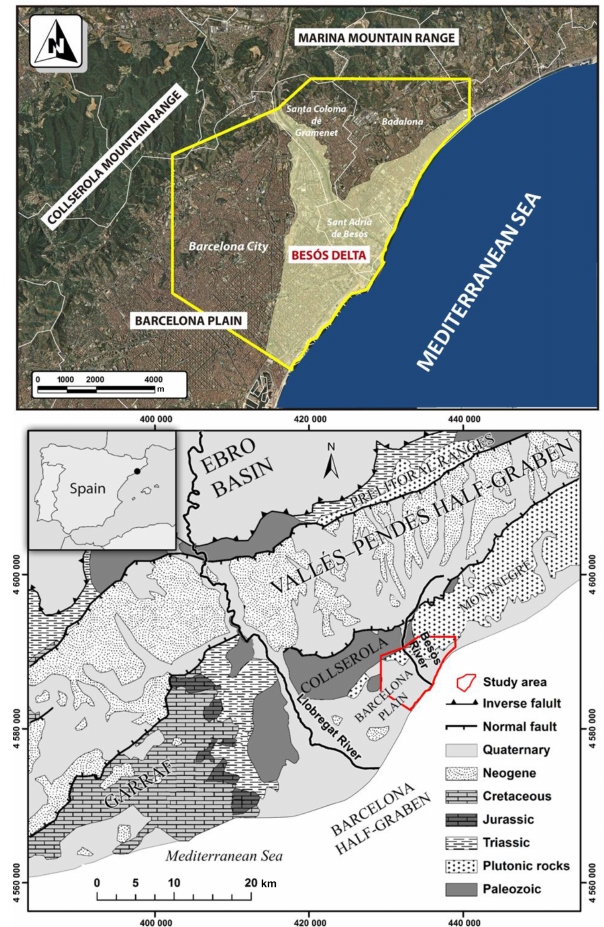
Figure 1. Top: orthophotograph of the northeastern Mediterranean coast of Spain covering the extent of the Barcelona study area (IGN PNOA). Note the intense urbanization of this region, hin- dering outcrop existence. Bottom: geological setting of Barcelona and surroundings. Coordinates are in Universal Transverse Merca- tor (UTM), zone